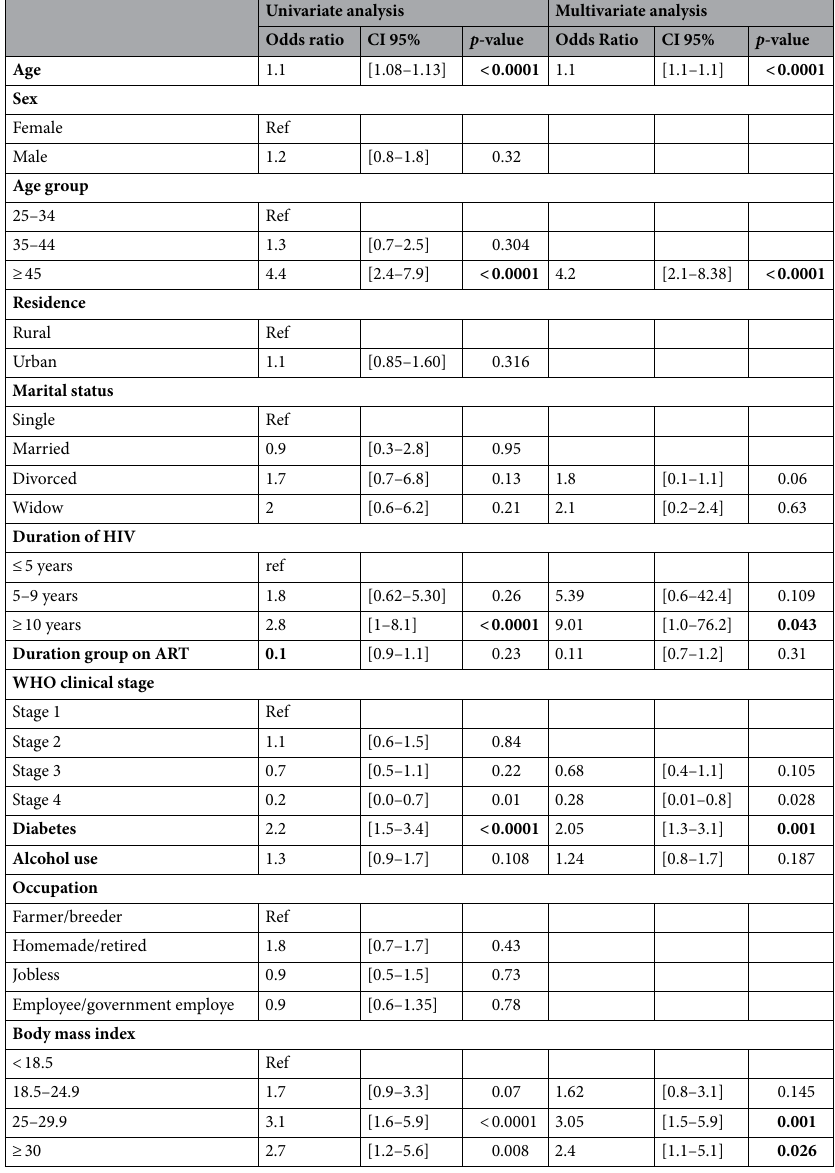
Table 2. Factors associated with hypertension among HIV infected patients under ART in Burundi. Significant values are in